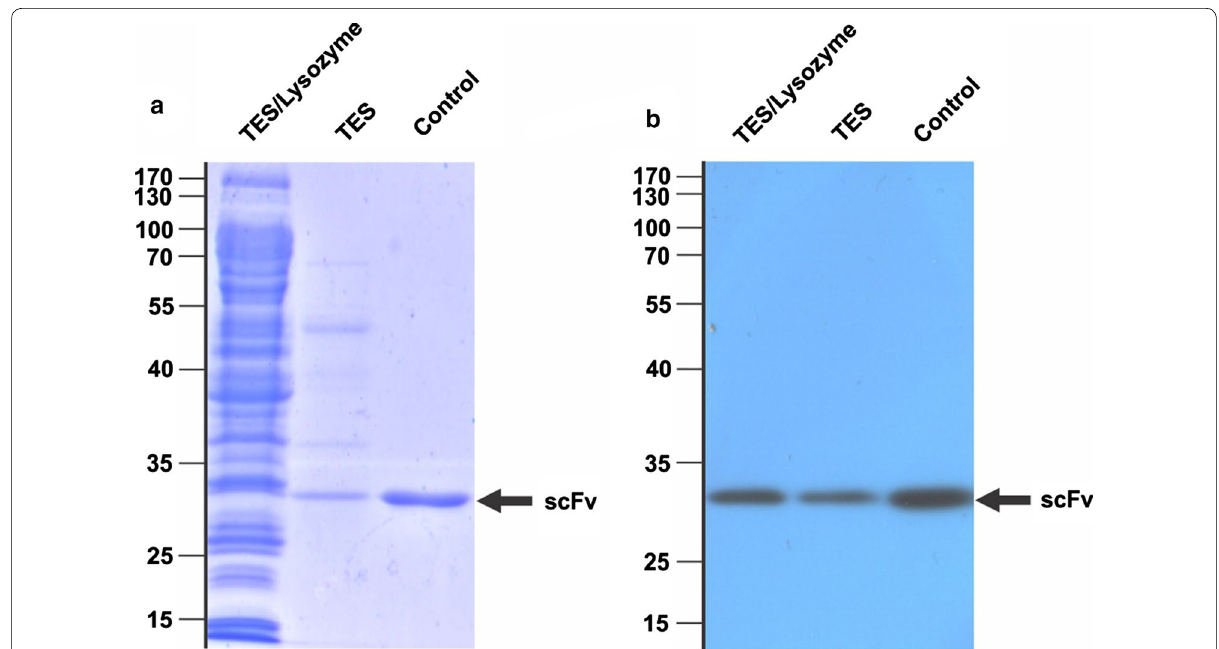
Fig. 5 Characterization of the optimal conditions. a , b display respectively SDS-PAGE and immunoblotting of the anti-G17-Gly scFv expressed at the mentioned optimal conditions. TES extraction shows much purer periplasmic fraction than the TES/lysozyme method. Control is the purified anti-G17-Gly